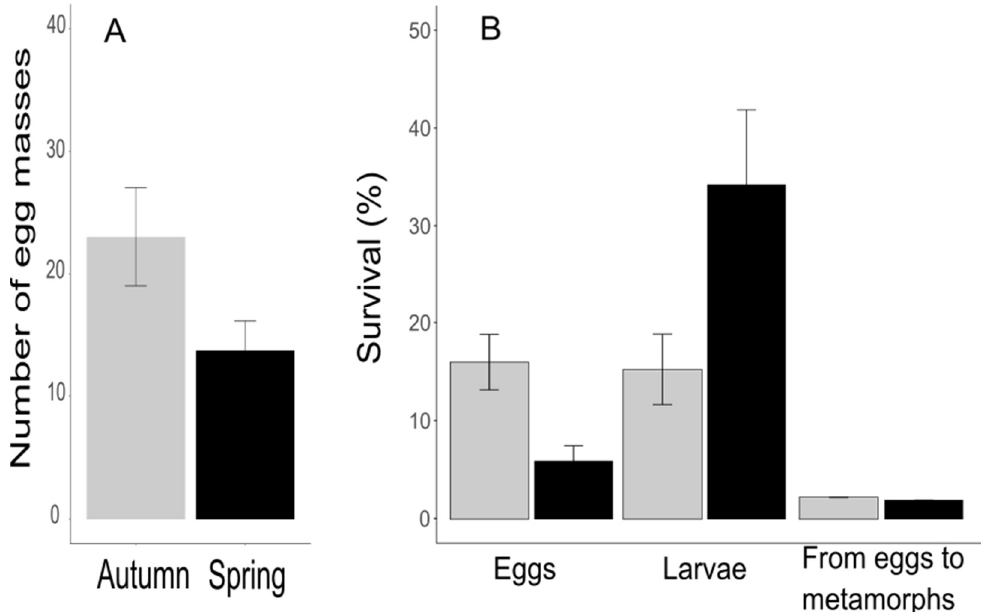
Figure 2: A Mean number of egg masses produced per season by the Parsley Frog for each recorded breeding event. B Mean survival rates during embryonic stage (hatching rate, n = 159), larval stage (n = 79) and from eggs to metamorphs (n = 163). Error bars are standard errors, among sites, among year. Autumn in grey and spring in black.